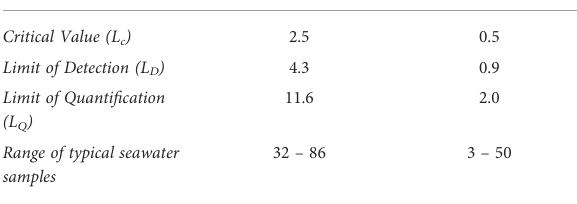
TABLE 1 Method validation results for analysis of DOC and TDN in seawater using the HTC method.